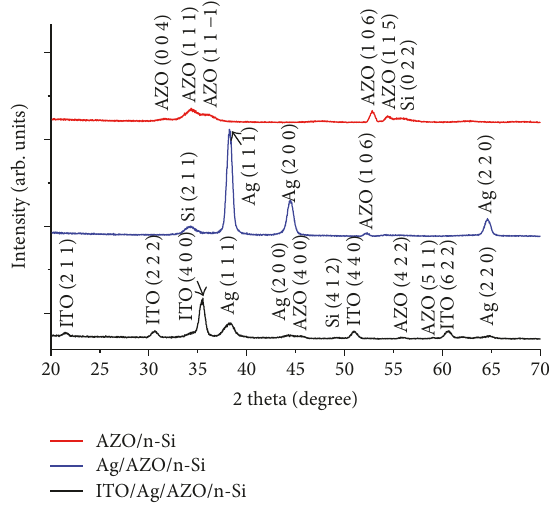
Figure 3: XRD patterns of the single AZO fi lm, Ag/AZO fi lm, and ITO/Ag/AZO fi lm deposited on